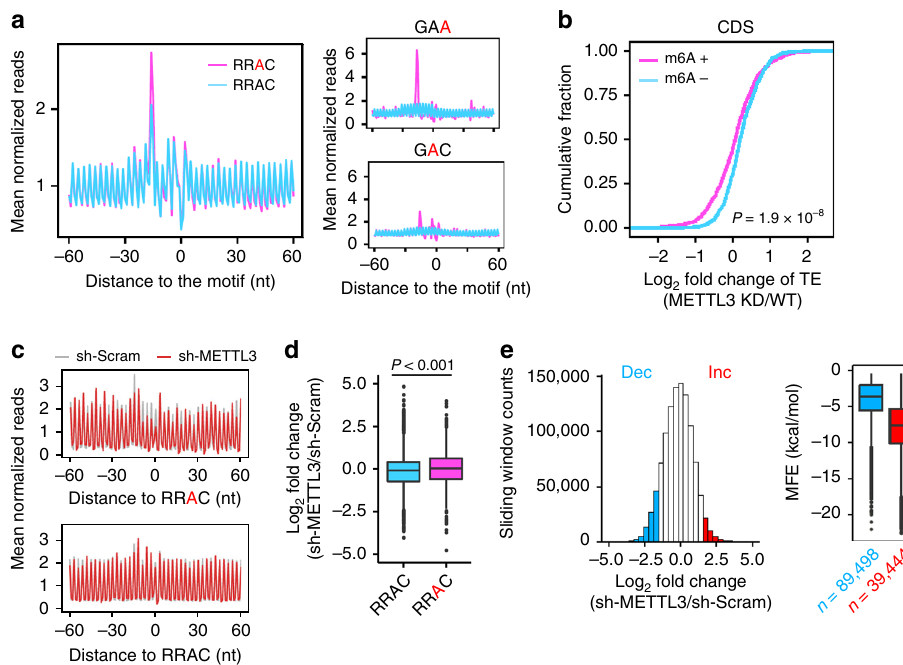
Fig. 2 Characterize the role of CDS m 6 A in translation ef fi ciency. a Aggregation plots show the mean ribosome densities along mRNA regions aligned to the RRAC motif with (pink line) or without (blue line) m 6 A modi fi cation. Right panels show the mean ribosome densities along mRNA regions aligned to GAA or GAC codons with (pink line) or without (blue line) m 6 A modi fi cation. A minus position value indicates upstream of m 6 A sites, whereas a positive value indicates downstream of m 6 A sites. The m 6 A site in RRAC motif or codons is highlighted by red. b The fold change of translation ef fi ciency upon METTL3 knockdown is plotted as accumulative fractions (Wilcox test, P = 1.9× 10 − 8 ) for mRNAs bearing CDS methylation (m 6 A + ) or not (m 6 A − ). Both groups have similar levels of basal TE. c Aggregation plots show the mean ribosome densities along mRNA regions aligned to the RRAC motif with (top panel) or without (bottom panel) m 6 A modi fi cation. Plots from cells with or without METTL3 knockdown are color coded. The m 6 A site in RRAC motif is highlighted by red. d From the same data sets as c , the fold change of ribosome accumulation upstream of the motif in response to METTL3 knockdown is calculated for transcripts with or without m 6 A modi fi cation (Wilcox test, P < 0.001). For the boxplot in d and e , the median value in each group is indicated by a center line, the box shows the upper and lower quantiles, whiskers shows the 1.5× interquartile range, and the outliers are indicated by points. e A histogram shows the distribution of changes of regional ribosome density in response to METTL3 knockdown. A sliding window of 30 nt in length with a step of 3 nt are used to calculate the local ribosome density. Regions with <1/3-fold (Dec, blue) and >3-fold (Inc., red) changes are highlighted by color coding. The right box plot shows the predicted minimum folding free energy (MFE) for regions with <1/3-fold (Dec) and >3-fold (Inc.) changes (Wilcox test, P < 2.2× 10 − 16 ). Source data are provided as a Source Data fi